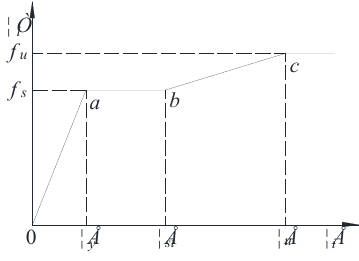
Figure 4. Stress-strain curve of steel.